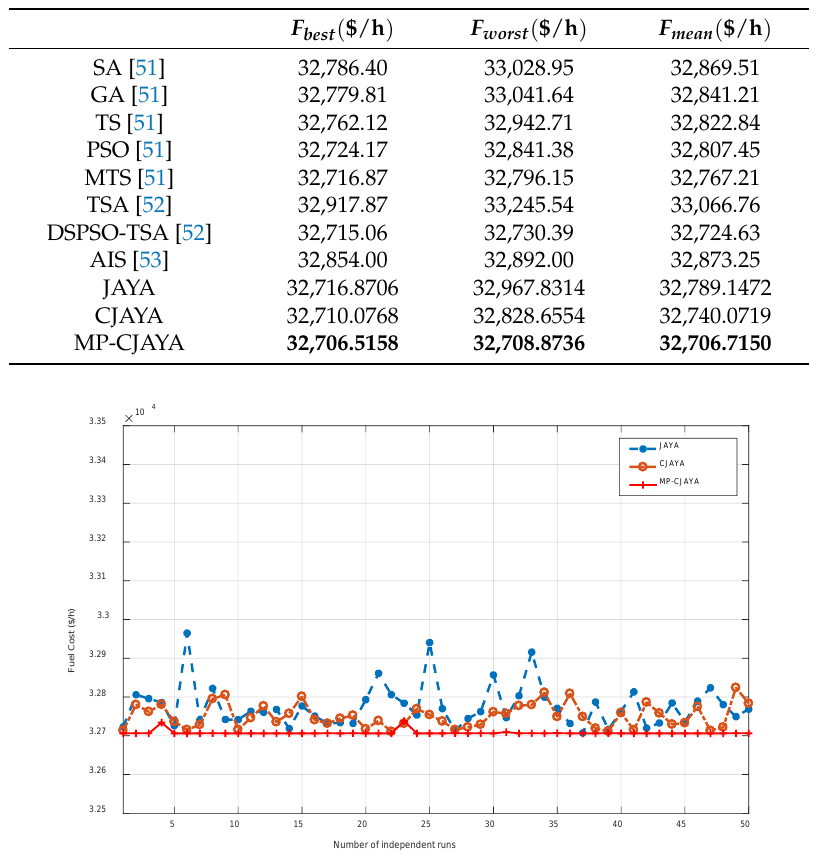
Figure 10. Fuel cost for 50 independent runs of 15-units system ( P D = 2630 MW).